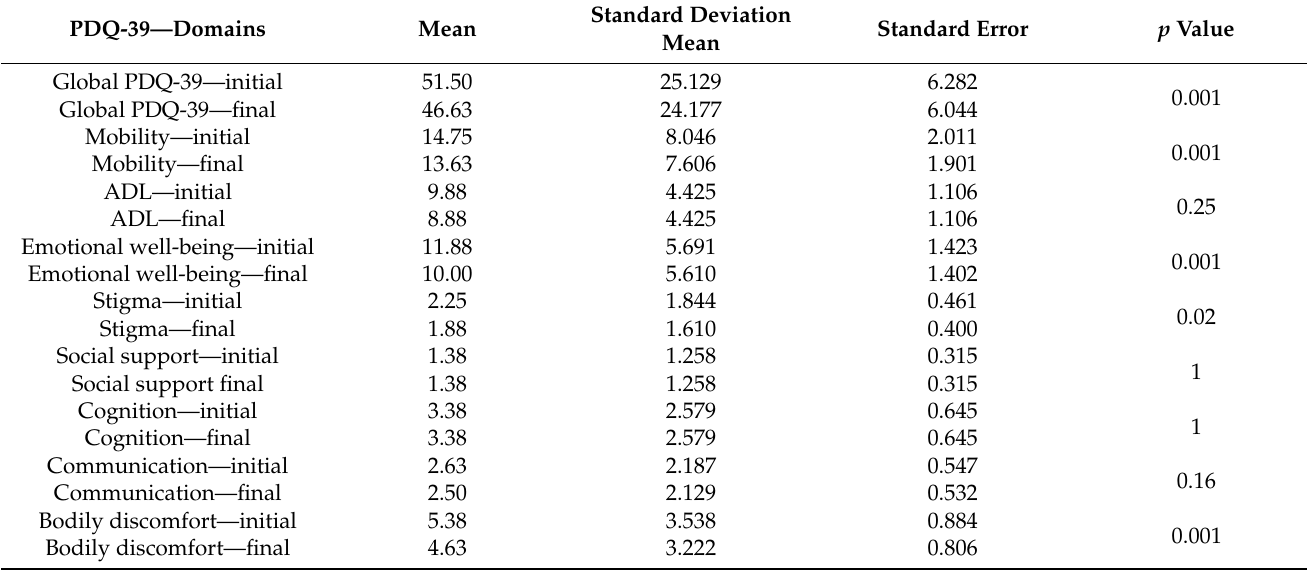
Table 4. Comparison of initial and final PDQ-39 scale values in the control group.